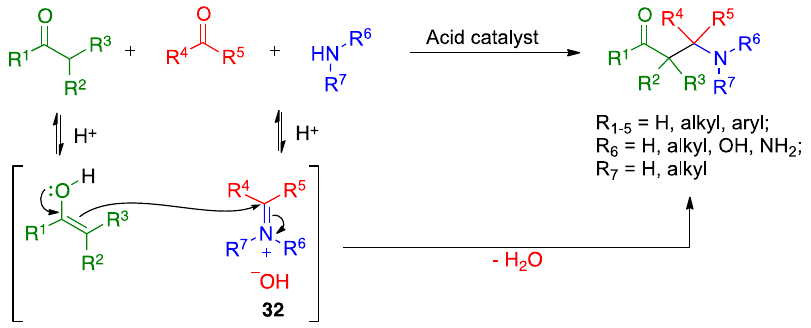
Figure 1. Some drugs that are synthesised using a Mannich reaction as the key step. The bond thus created is marked in